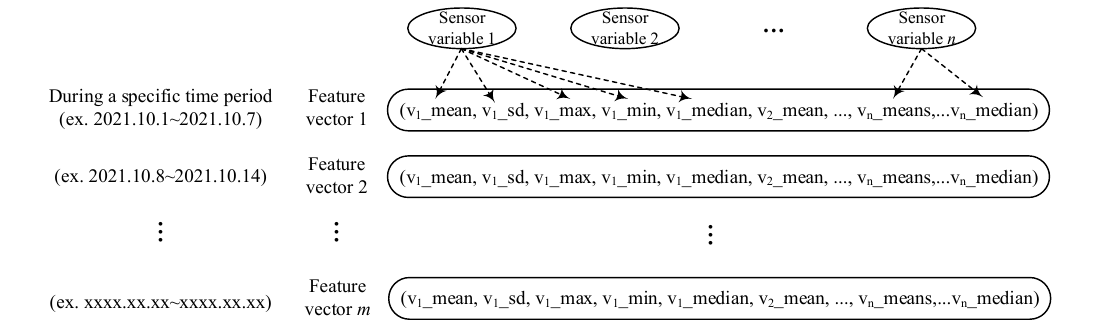
Figure 2. Structure of feature vectors.